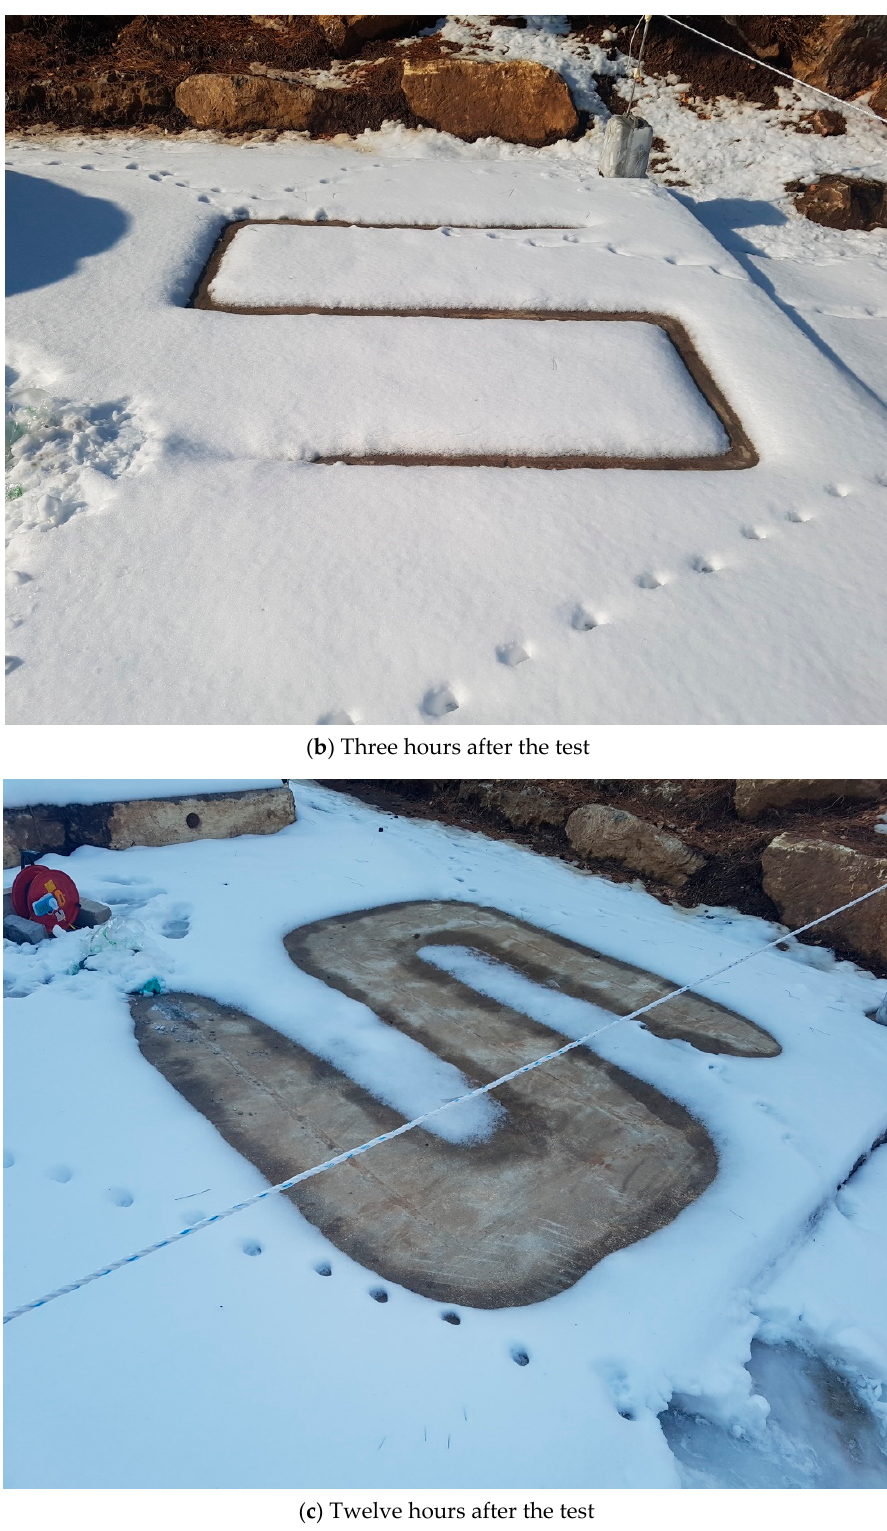
Figure 18. Deicing after snow accumulation.